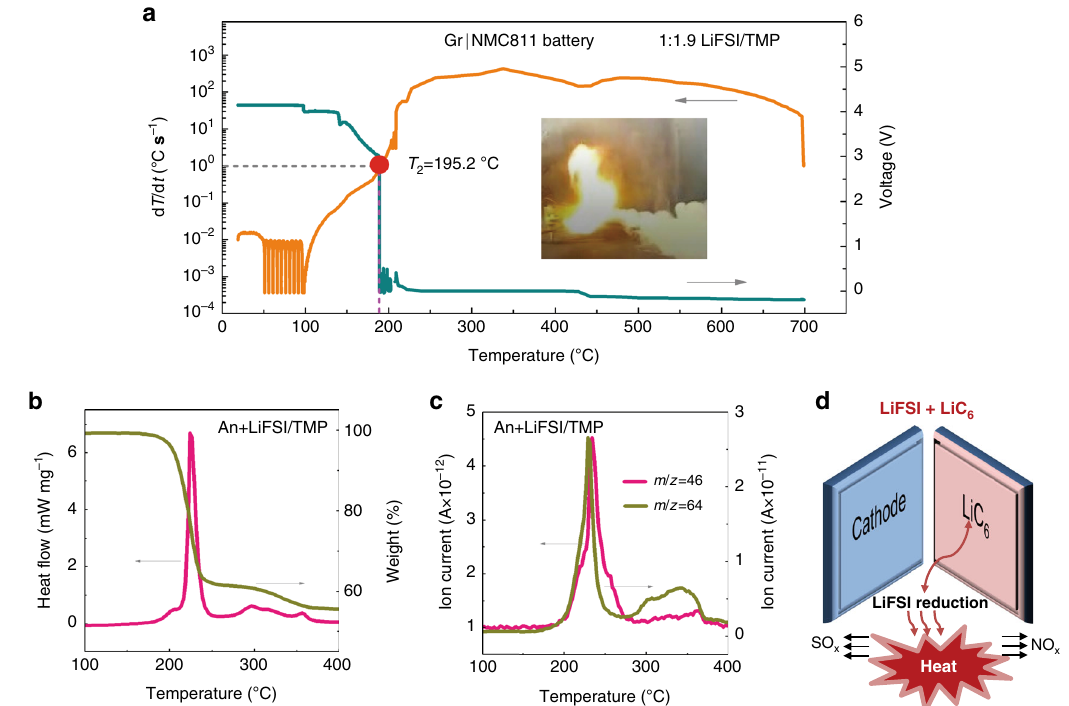
Fig. 6 Thermal runaway of Gr|NMC811 battery with non- fl ammable concentrated LiFSI/TMP. a The temperature dependence of d T /d t of the Gr|NMC811 battery with the concentrated LiFSI/TMP. The inset shows the combustibility of battery in the lateral heating test. b DSC trace and TGA curve of the An + LiFSI/TMP sample. c NO 2 ( m / z = 46) and SO 2 ( m / z = 64) gas evolution of the An + LiFSI/TMP sample. d Illustration of the proposed thermal runaway mechanism of LiFSI-based concentrated electrolytes in Gr|NMC batteries. The considerable heat generated by the reaction of LiFSI + LiC 6 triggers the Gr| NMC batteries to thermal runaway.